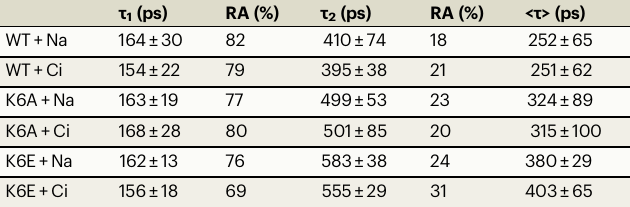
PCC6803 wildtype,K6A, or K6E cells inthepresence ofNaCl(+Na) or CO 2 /HCO 3 − (+Ci). RA =Relative Amplitude. n =6 independent replicates.Source data areprovided as a Source Data fi